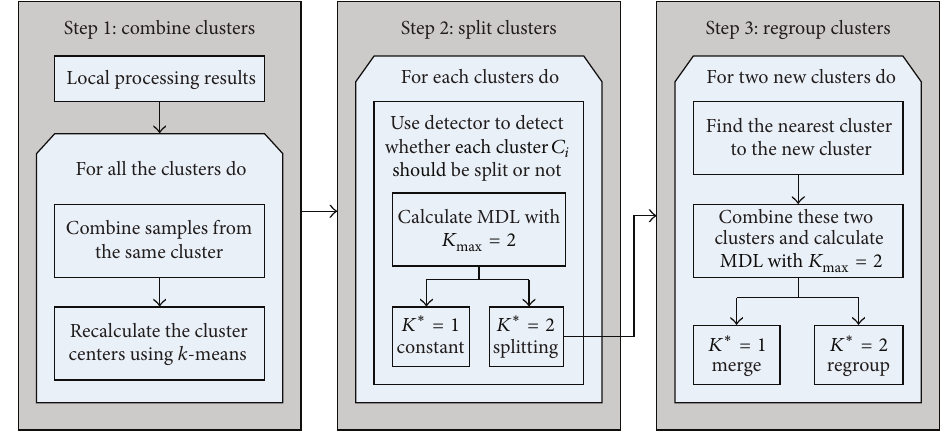
Figure 7: The main procedures of clustering.